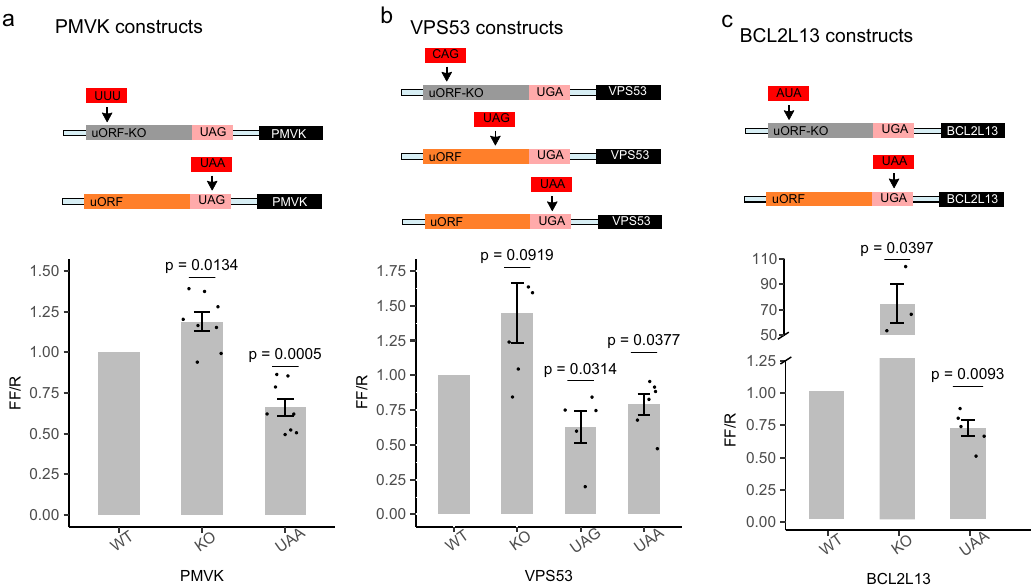
Fig. 5 Reporter gene assays for translated uORF stop-introducing and stop-strengthening variants. Dual-luciferase reporter assay quanti fi es relative expression for uORFs with UTC and stop-strengthening variants associated with EHR phenotypes by PheWAS. Experimental 5 ′ UTRs for a PMVK , b VPS53 , and c BCL2L13 for uORF KO, stop-strengthened, or stop-introduced variants are shown. Bars represent co-transfected Fire fl y to Renilla Luciferase luminescence ratios normalized to associated wild-type 5 ′ UTRs in HEK293T cells measured 48 h post-transfection. P values from one-sample t -test for each condition are displayed above each column. Error bars represent mean + SEM of at least three independent experiments. Raw luciferase measurements are included in the Source Data fi